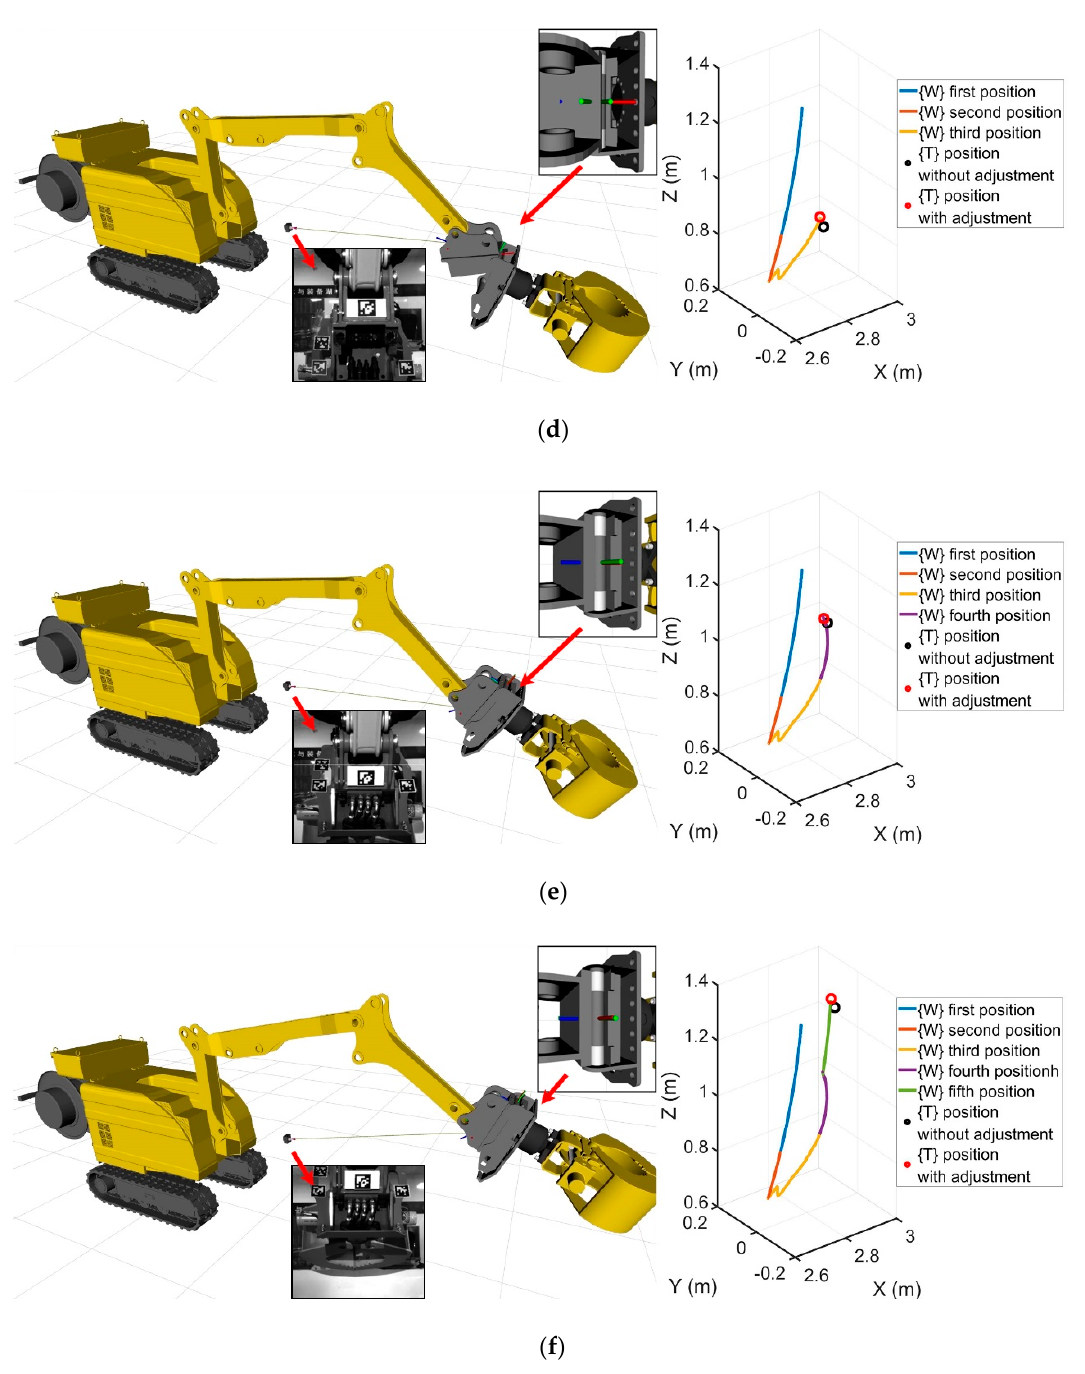
Figure 9. ( a ) Beginning of the experiment. ( b ) End of the first stage. ( c ) End of the second stage. ( d ) End of the third stage. ( e ) End of the fourth stage. ( f ) End of the experiment.